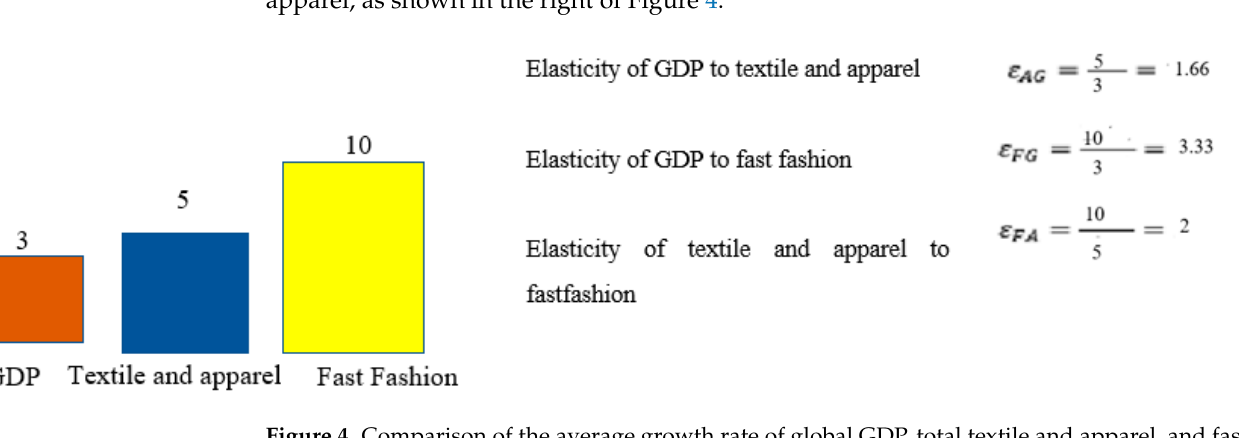
Figure 3. Concept of supra-functionality beyond economic value. Sources: [7–9].